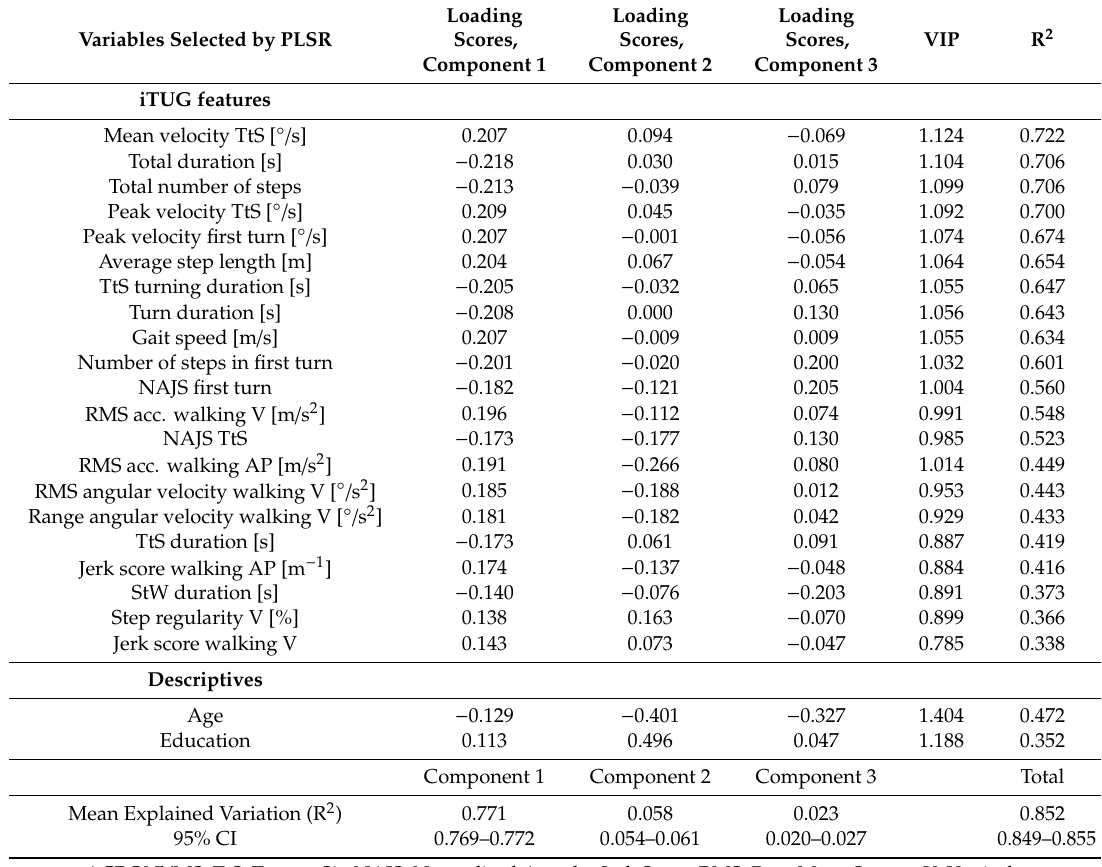
Figure 5. The VIP scores (light grey) and R 2 (dark grey) of the iTUG features selected in the PLSR model. The horizontal lines represent the lower (0.83), middle (1) and upper (1.21) cut-off values used for interpreting the VIP of individual predictor variables. 3.2. PLSR of Standard Clinical Tests vs. the CBMS In the PLSR model, with standard clinical test scores as predictors and CBMS total score as the response variable, we found that the first two components predicted the CBMS total score with an R 2 of 0.825 (95% CI 0.822–0.828, see Table 3).